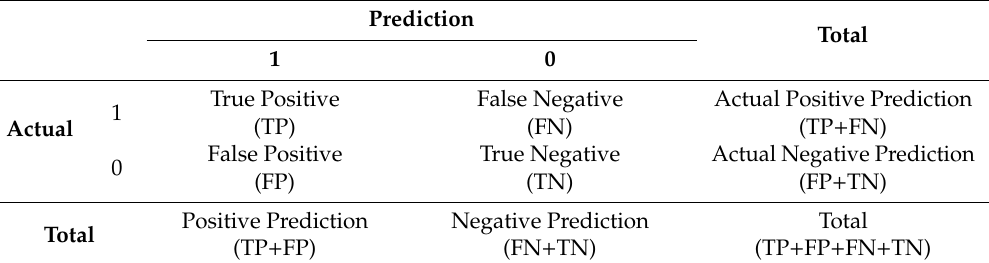
Figure 7. Feature extraction of landslides by transfer learning. Table 1. Related indicators of confusion